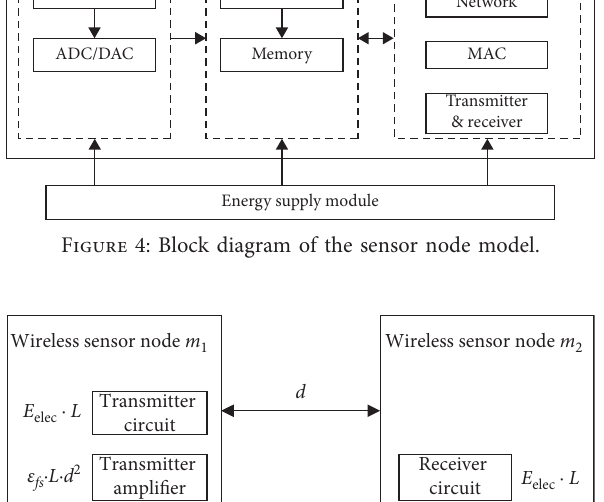
Figure 4 is a block diagram of a conventional wireless sensor network node module.